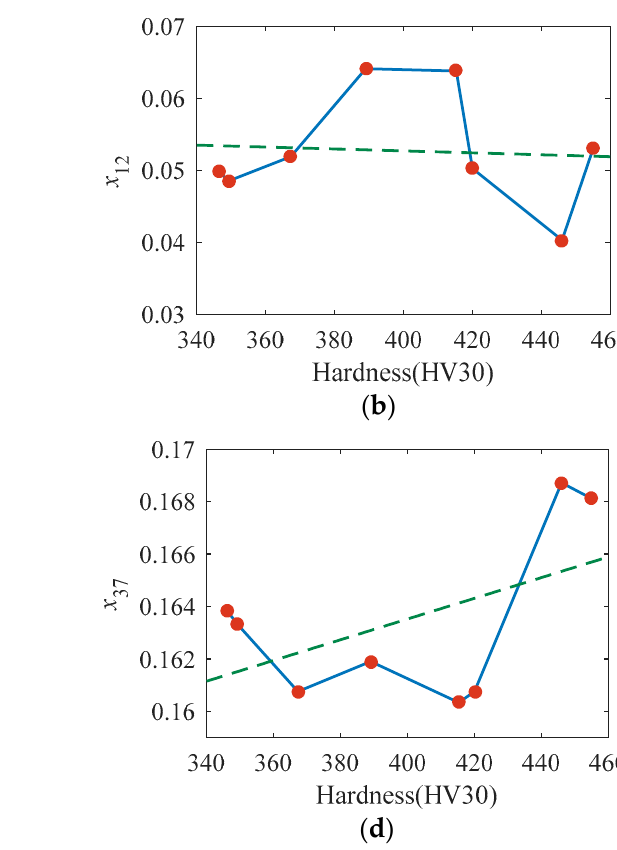
Figure 8. ( a – d ) demonstrate the dependency of x 7 , x 12 , x 19, and x 37 on the surface hardness,